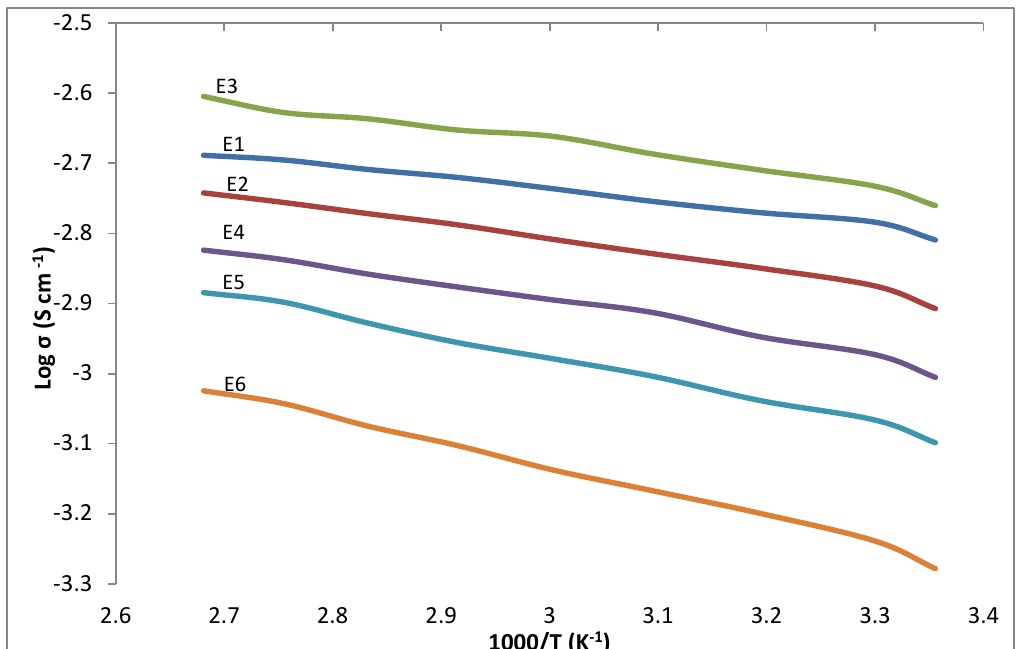
Fig.1: The alteration of conductivity plot vs the reciprocal temperature for different electrolytes